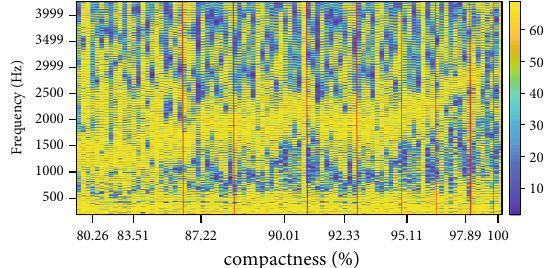
Figure 8: Frequency spectrum after 55(L) N hammering force is reduced by